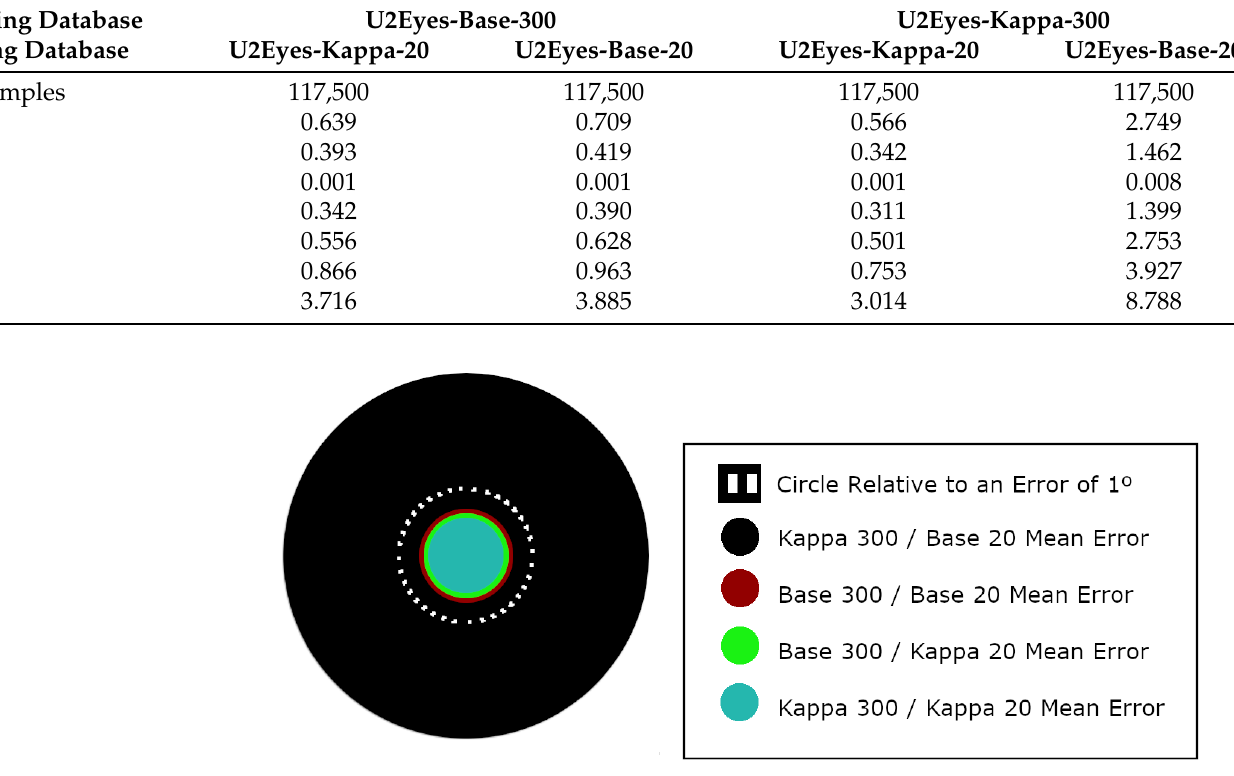
Figure 8. Visual comparison of the mean results presented in Table 4. The black circle is the equivalent representation of an error of 2.749 ◦ (model trained over Kappa-300 and tested over Base-20); the brown circle, an error of 0.709 ◦ (Base-300/Base-20); the green circle, an error of 0.639 ◦ (Base-300/Kappa-20); and the blue circle, an error of 0.566 ◦ (Kappa-300/Kappa-20). As a base reference, the dotted white lane represents an error of 1 ◦